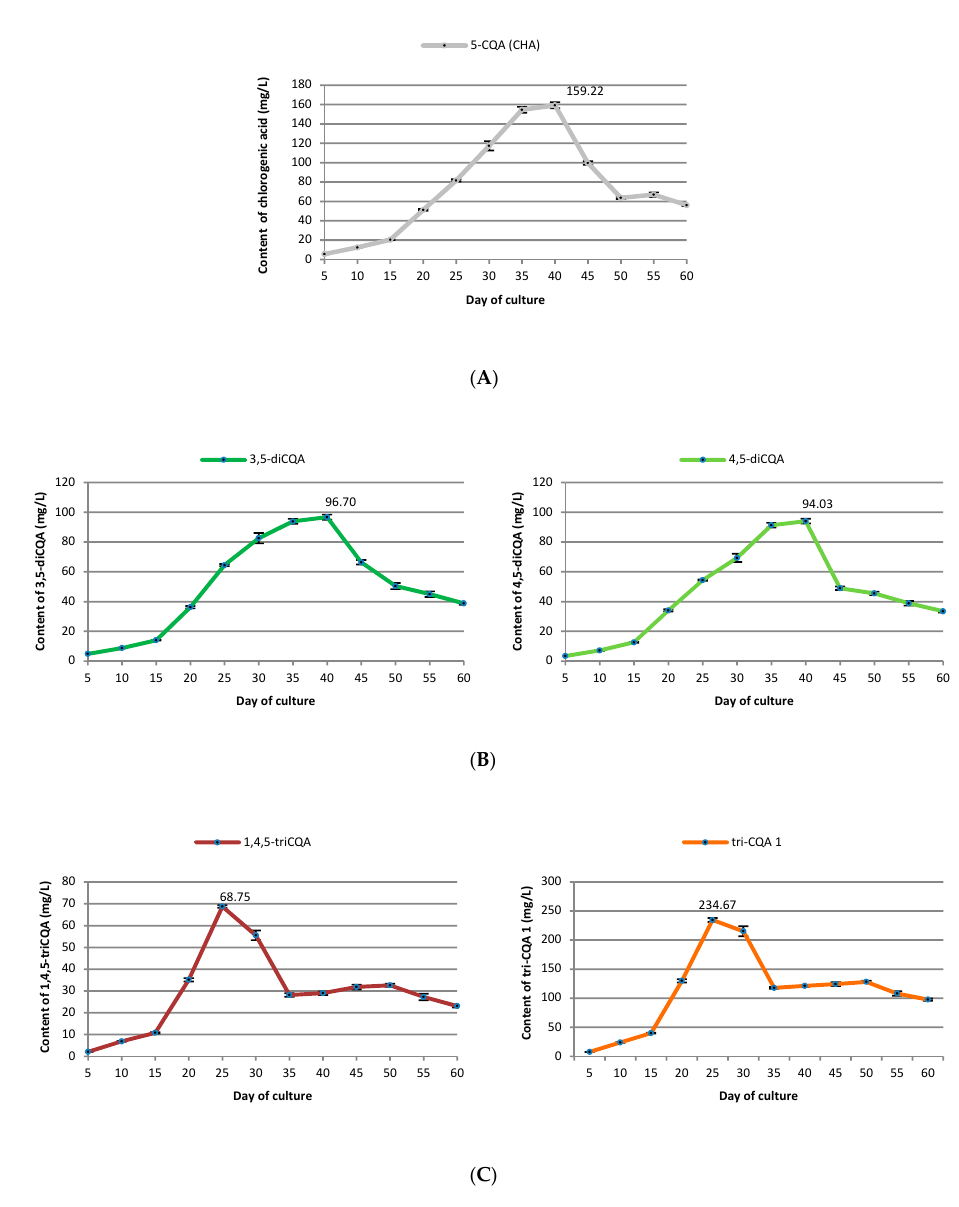
Figure 11. The changes in the content of caffeoylquinic acid derivatives (mg L − 1 ) ( A ) 5- O - caffeoylquinic acid, ( B ) 3,5-di- O -caffeoylquinic acid and 4,5-di- O -caffeoylquinic acid, ( C ) 1,4,5-tri- O -caffeoylquinic acid and tentatively-identified tri- O -caffeoylquinic acid 1 derivative during the growth cycle of R. carthamoides transformed roots cultured for 60 days in 50 mL of liquid WPM medium supplemented with 3% sucrose in a 300 mL Erlenmeyer flask, in light conditions (16/8-h light/dark photoperiod) on a rotary shaker at 80 rpm. The results are means values ± SE of three replicates for each time point of the growth curve ( n = 9). 5-CQA (CHA)-5- O -caffeoylquinic acid (chlorogenic acid); 3,5-diCQA-3,5-di- O -caffeoylquinic acid; 4,5-diCQA-4,5-di- O -caffeoylquinic acid; 1,4,5-triCQA-1,4,5-tri- O -caffeoylquinic acid; tri-CQA 1 - tricaffeoylquinic acid derivative.